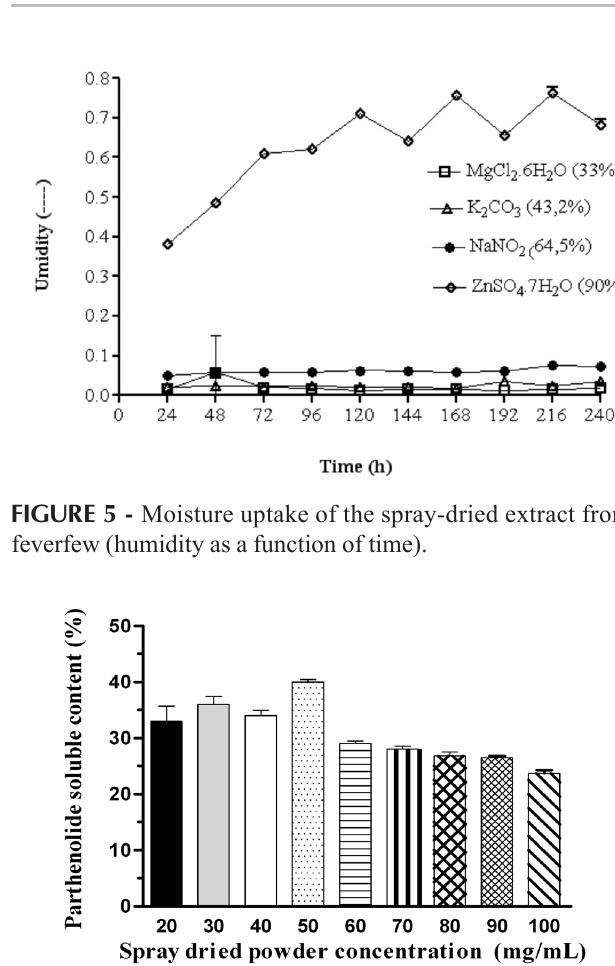
FIGURE 6 - Parthenolide soluble content in phosphate buffer pH 7.4 of feverfew spray-dried extract, spray powder concentration (mg/mL) x parthenolide content